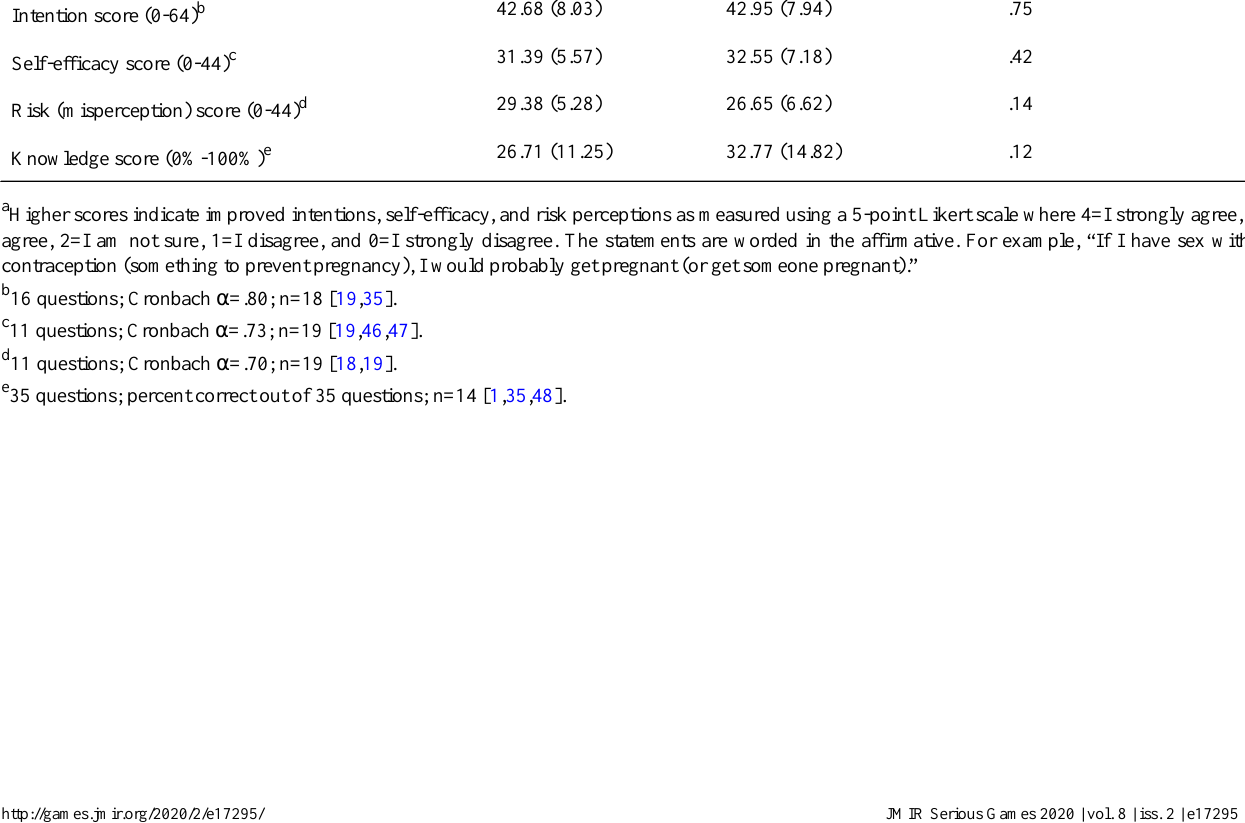
P value (baseline to follow-up)12-week follow-up, mean (SD)Baseline, mean (SD)Mean outcome summary scores